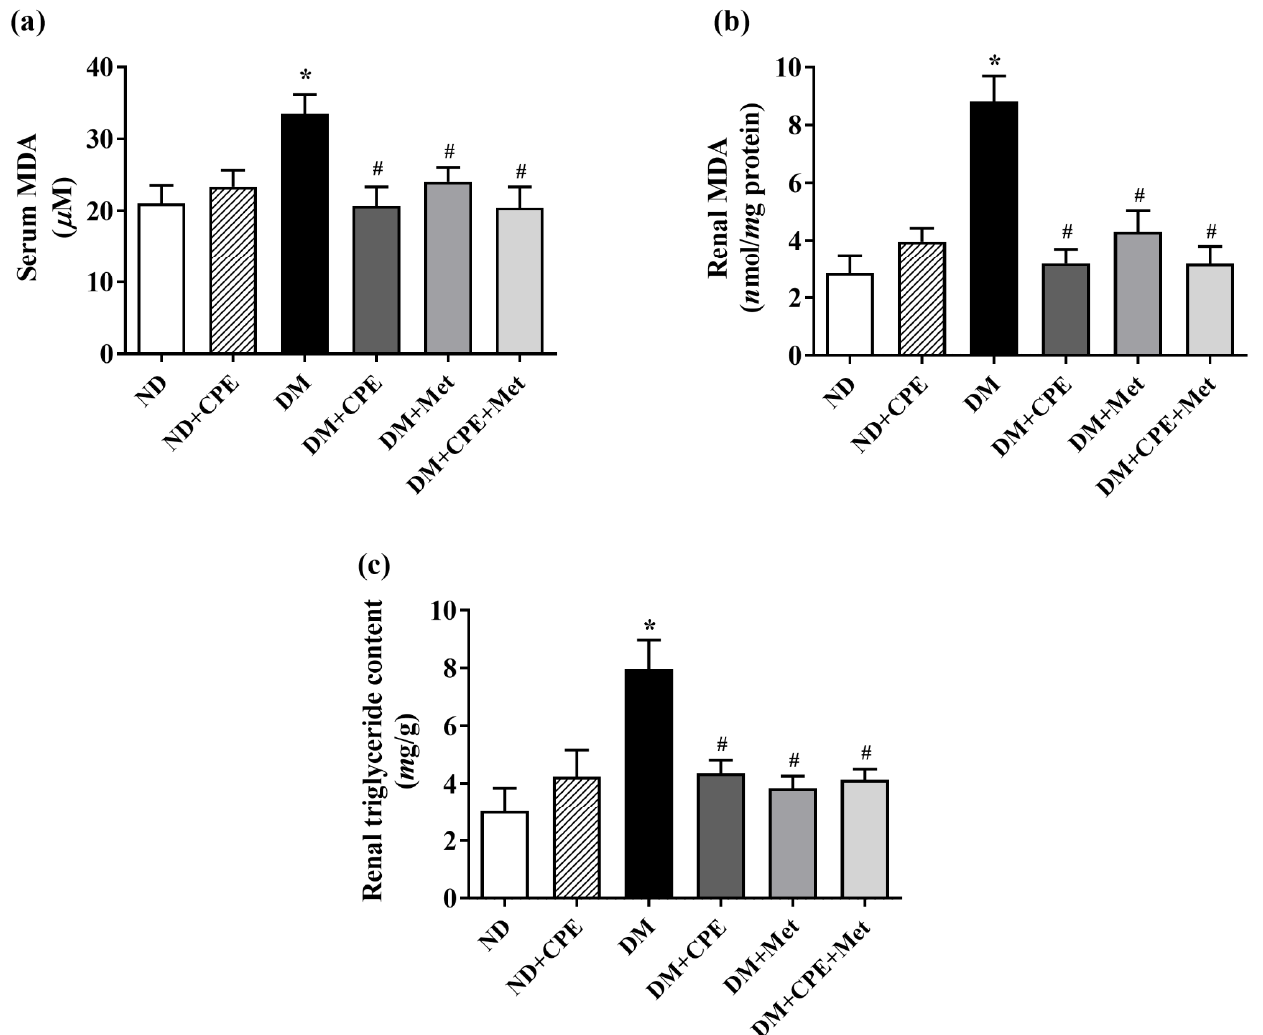
Figure 2. Effect of CPE on oxidative stress determined by lipid peroxidation as indicated by ( a ) serum malondialdehyde (MDA), ( b ) renal cortical MDA, and ( c ) total renal triglyceride content in T2D rats. Data are expressed as mean ± S.E.M ( n = 6). * p < 0.05, significantly different from ND; # p < 0.05, significantly different from DM.